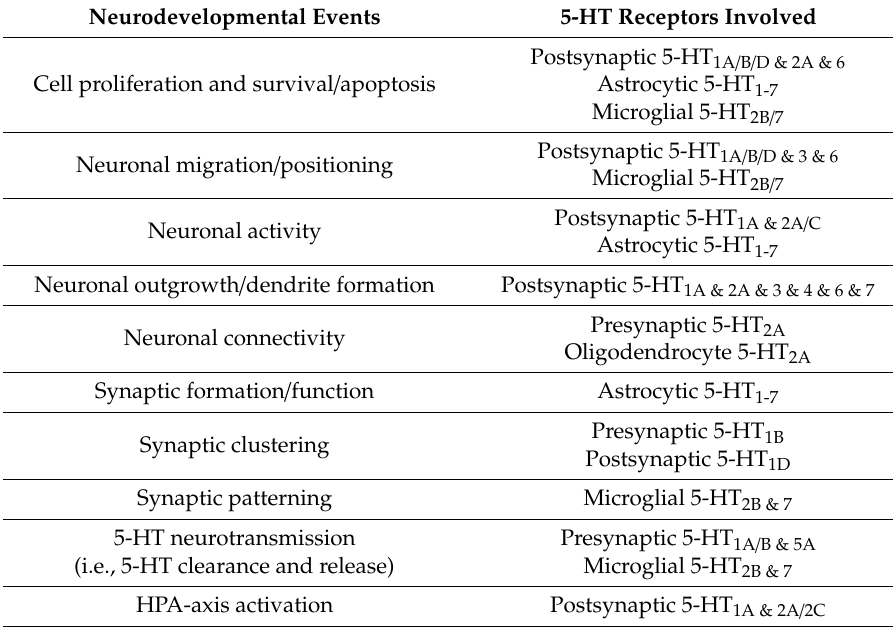
Table 1. 5-HT receptor involvement in neurodevelopmental